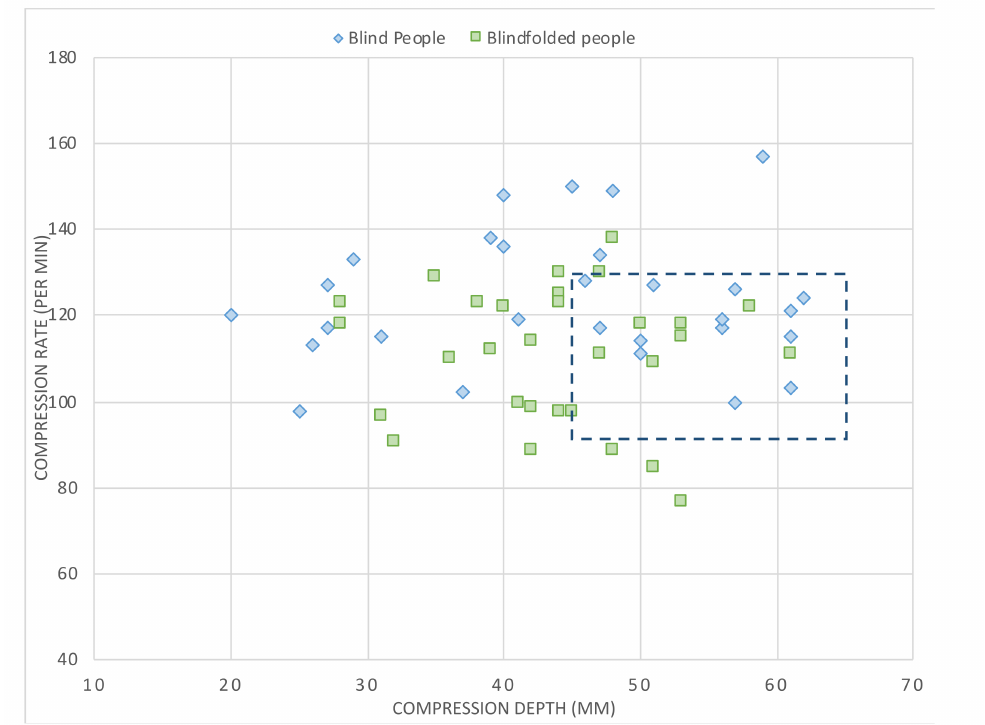
Figure 3. Scatter plot of the mean chest compression rate (compressions per minute) and depth (millimetres). The red square indicates the target, indicated by current guidelines. The dashed square represents an arbitrary expanded target with CC depth from 45 to 65 mm and CC rate from 90 to 130